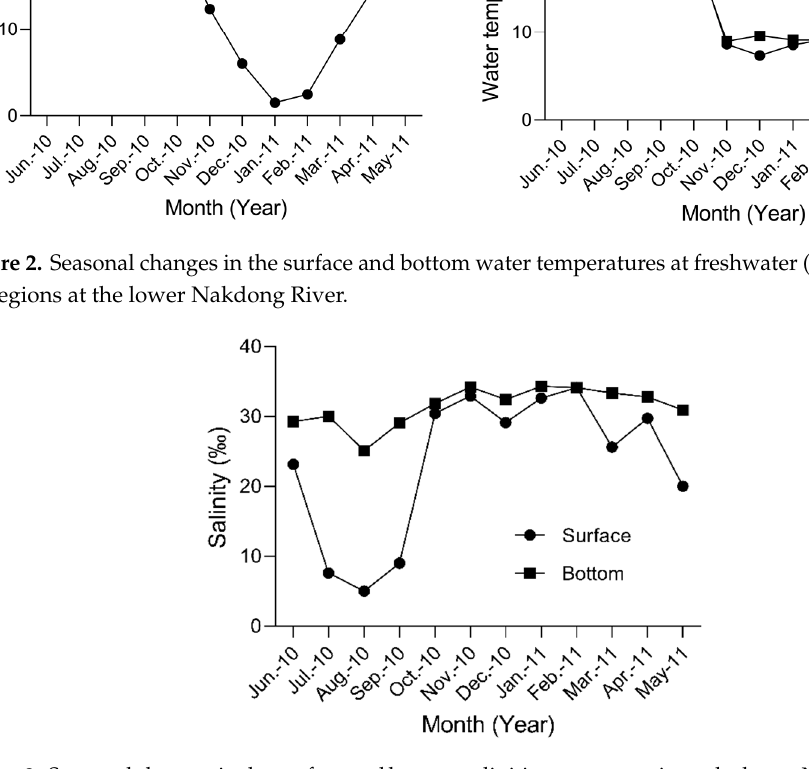
Figure 3. Seasonal changes in the surface and bottom salinities at estuary site at the lower Nakdong River.